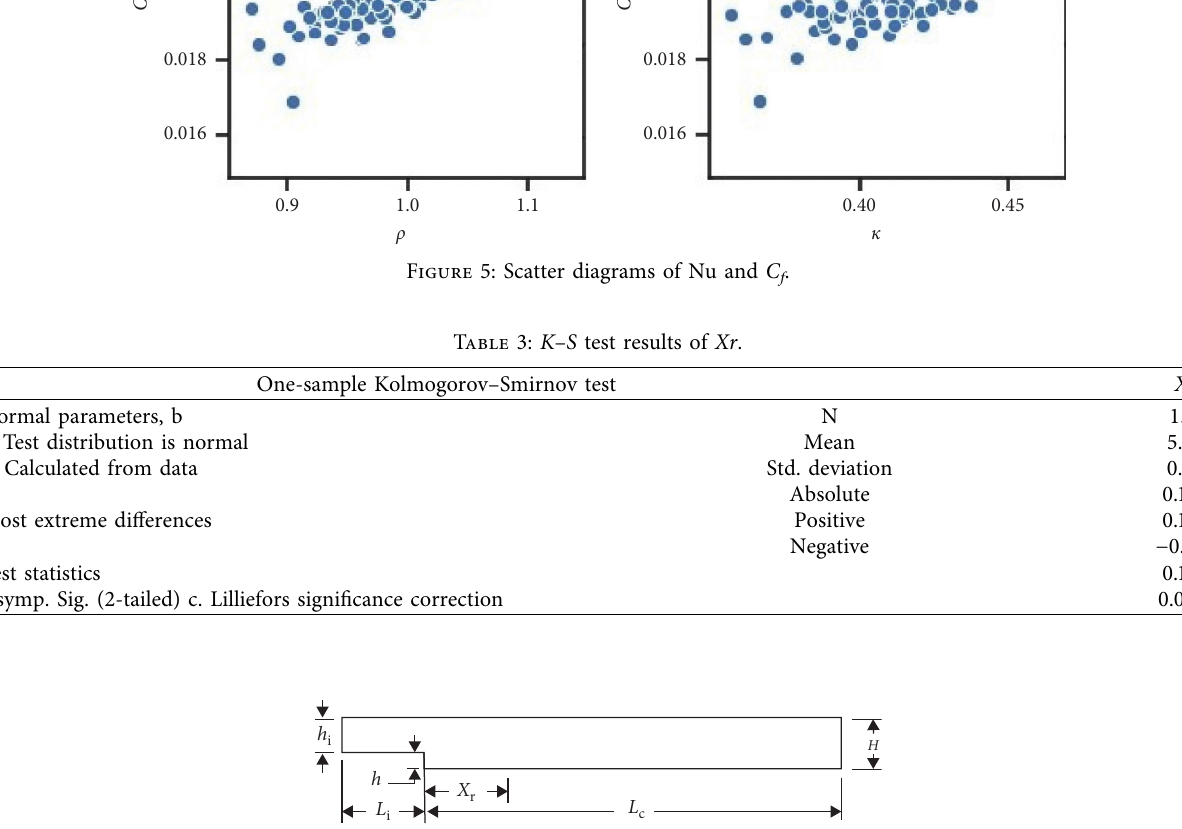
Figure 6: Backward-facing step geometry from Dunn